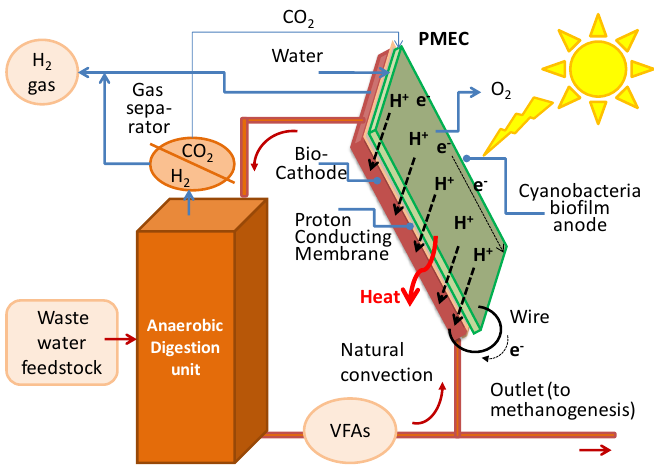
Figure 2. Integration of the PMEC photosynthetic microbial electrochemical cell with DF.